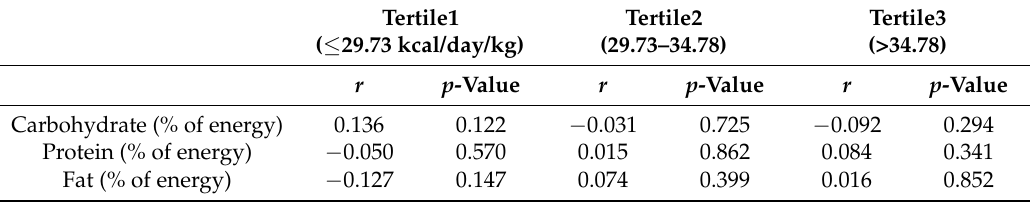
Table 7. Partial correlation coefficients between eating behaviors and the tertiles of